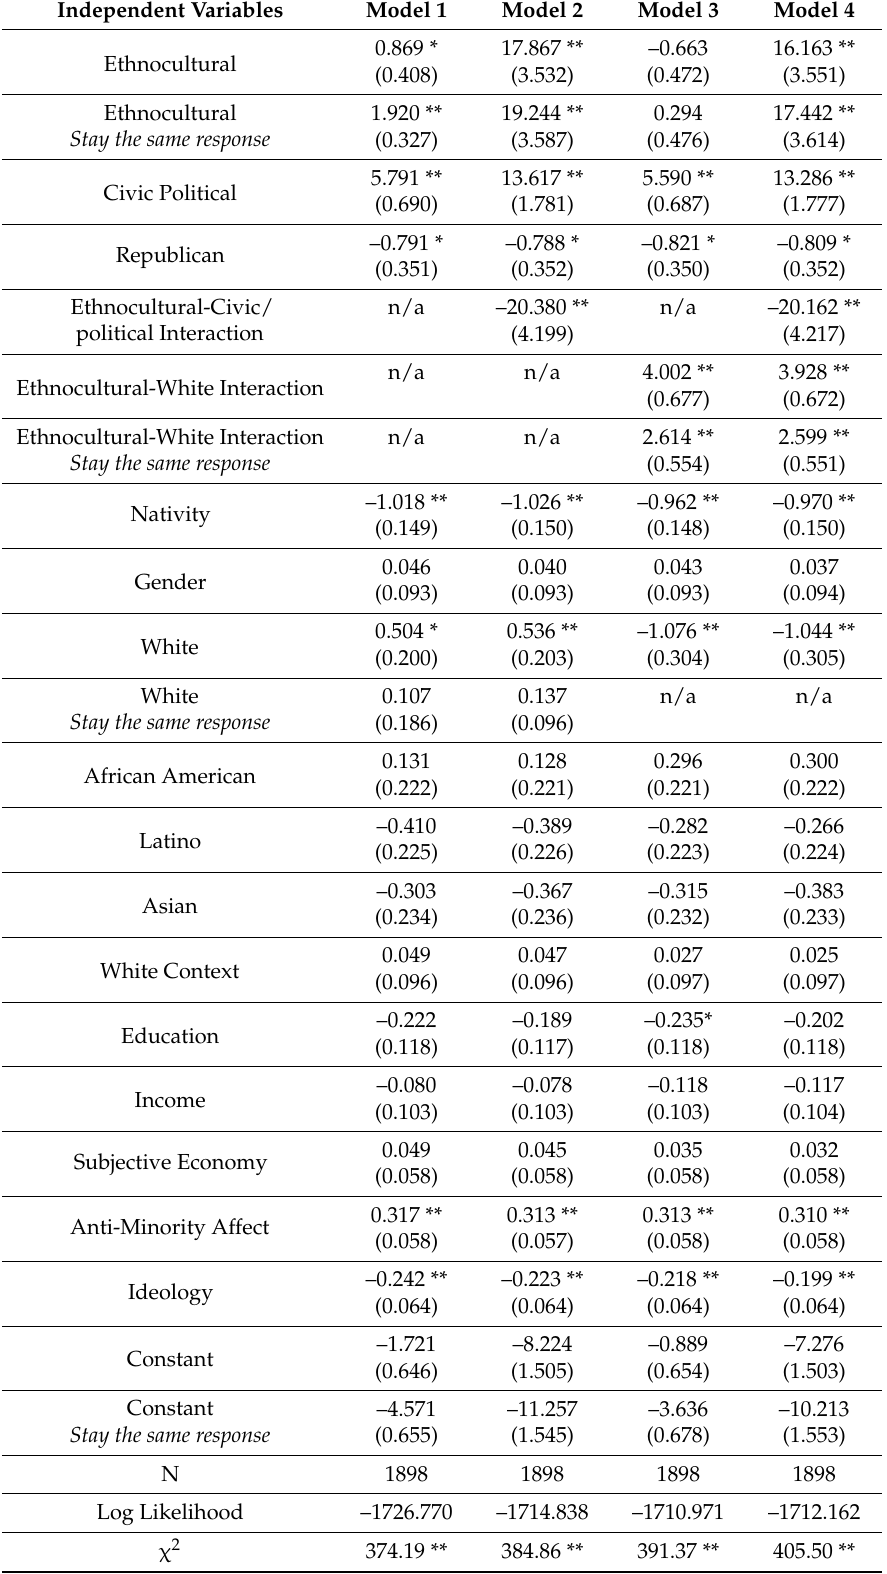
Table 3. The relationship of citizenship dimensions on attitudes towards immigration: a partial proportions ordinal logit